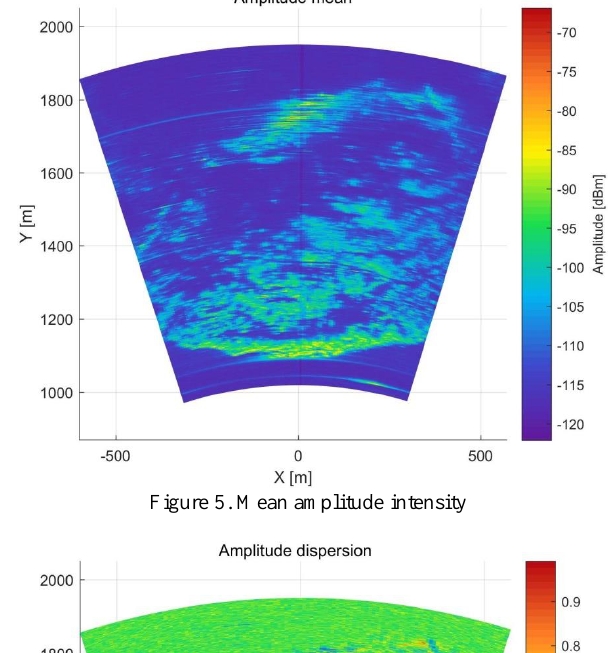
Figure 4. The ground-based SAR interference measurement flow chart